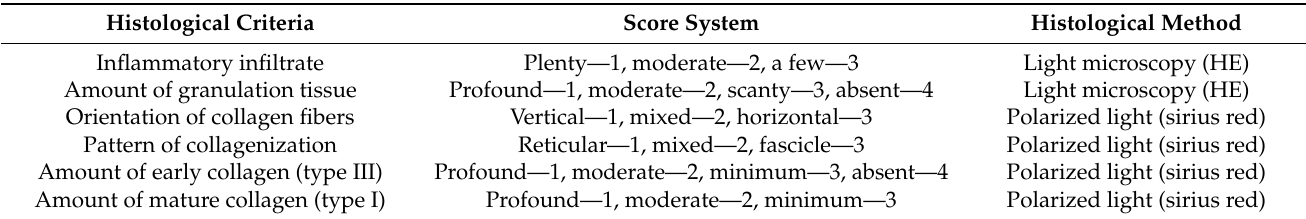
Table 1. Parameters assessed to calculate wound repair